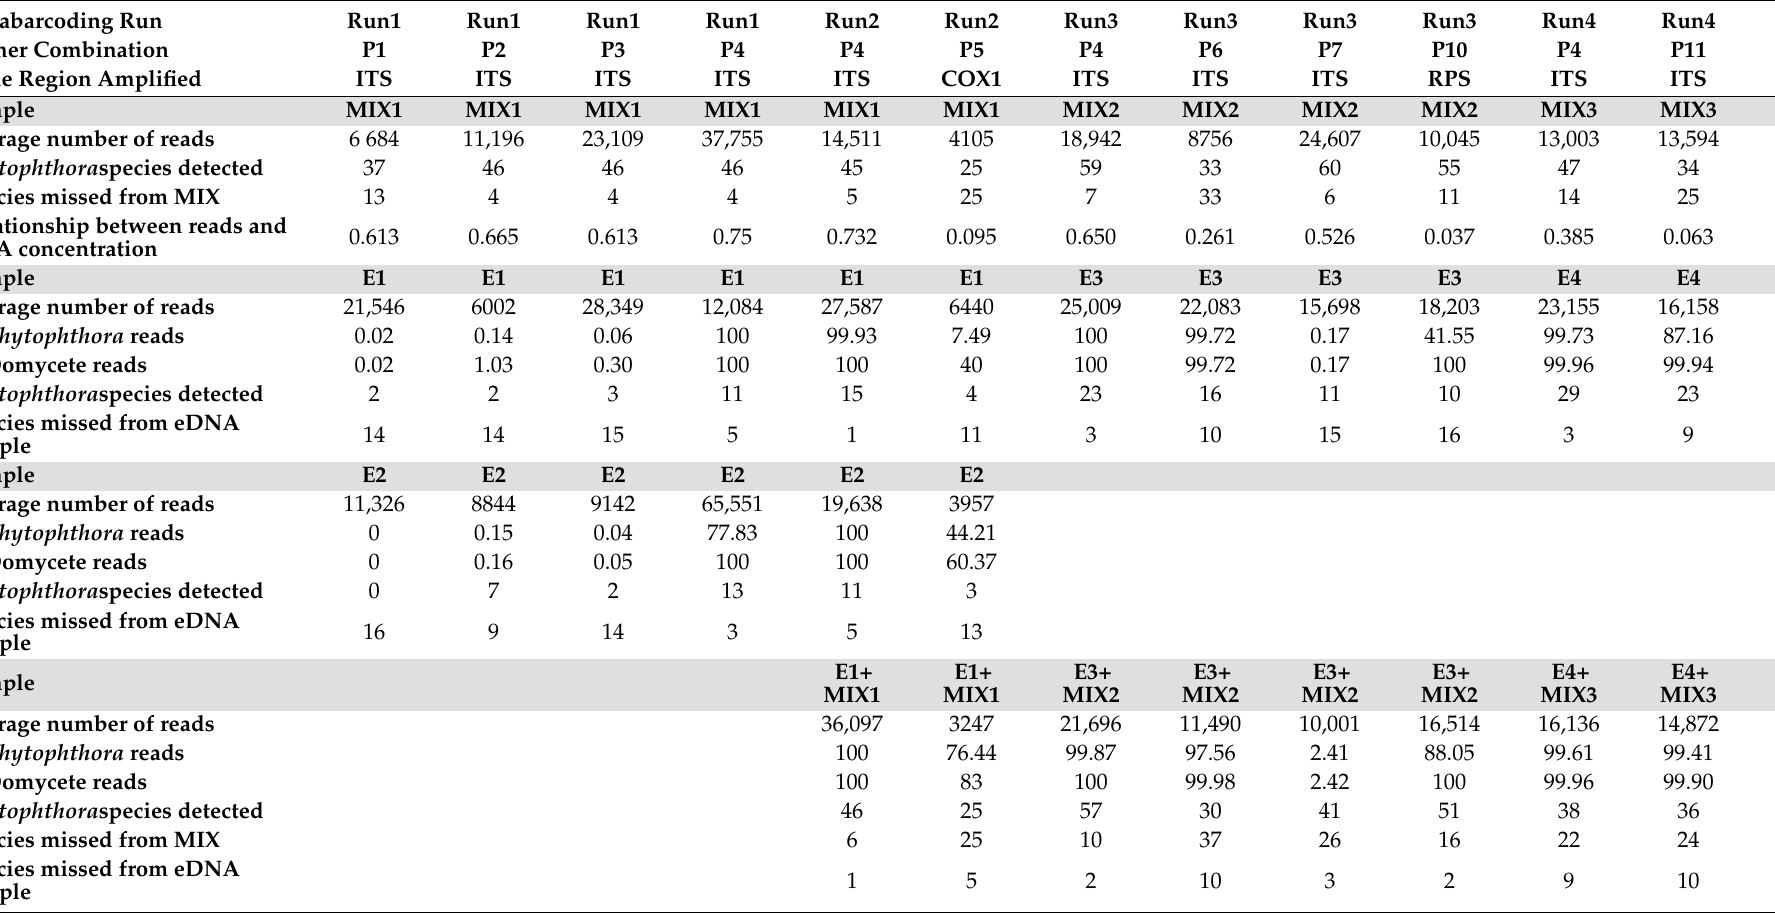
Table 3. Summary data for four metabarcoding runs for the mock community (MIX1–3) and the four eDNA samples (E1-E4) and for the combination of